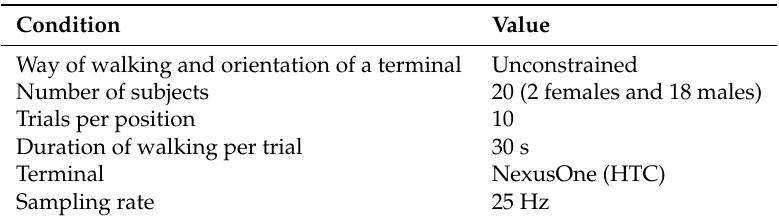
Table 5. Condition of data